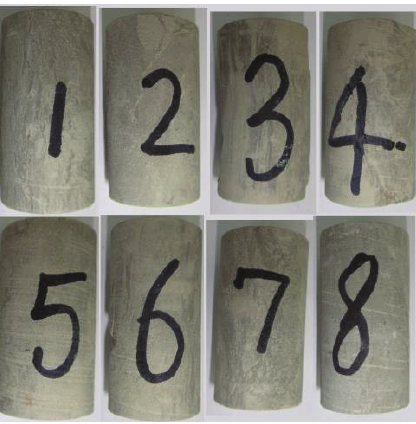
Figure 5: Standard samples of shale.